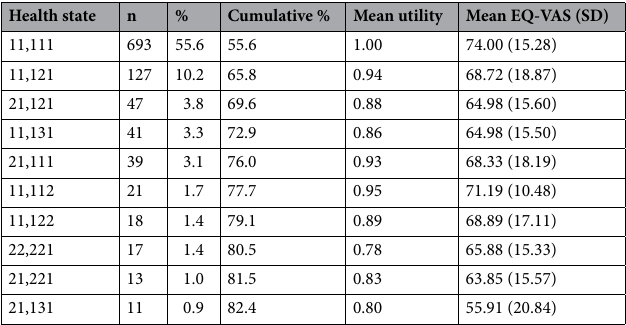
The EQ-5D-5L utility index and VAS scores stratified by different participant characteristics are presented in Table 2. The differences in the EQ-5D-5L utility index and VAS scores among different levels of age, education, spouse/single, per capita monthly actual income, alcohol consumption, high-fat diet, with stroke and anxiety, depression and poor sleep quality were statistically significant ( P < 0.05) (Table 2). Factors associated with having problems in each EQ‑5D dimension. The risk factors for having problems in each EQ-5D dimension, as determined by multiple logistic regression analysis, are shown in Fig. 1 and Table S1. Females and older CHD patients had an increased risk of suffering from PD [OR 1.7 (1.05–2.73) and 1.63 (1.12–2.37) respectively]. Higher education decreased the risk of having SC, UA, and PD problems. CHD patients without spouse had an increased risk of suffering from MO [OR 1.64 (1.10–2.47)] and UA [OR